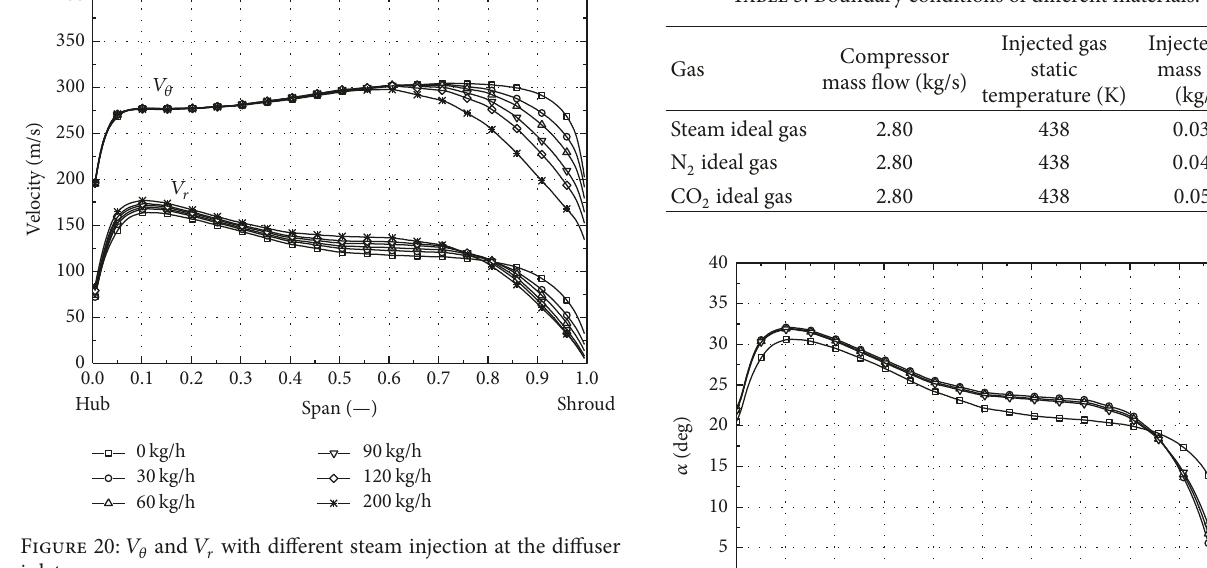
Table 3: Boundary conditions of different materials.